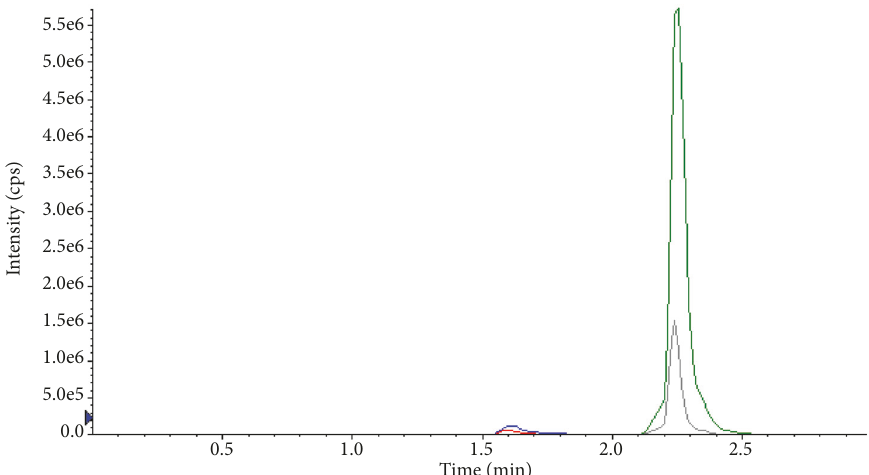
Figure 2: Chromatogram of analytes/ISTDs injected on high purity C 18 column (100 × 4.6 mm, 3.5 𝜇 m).